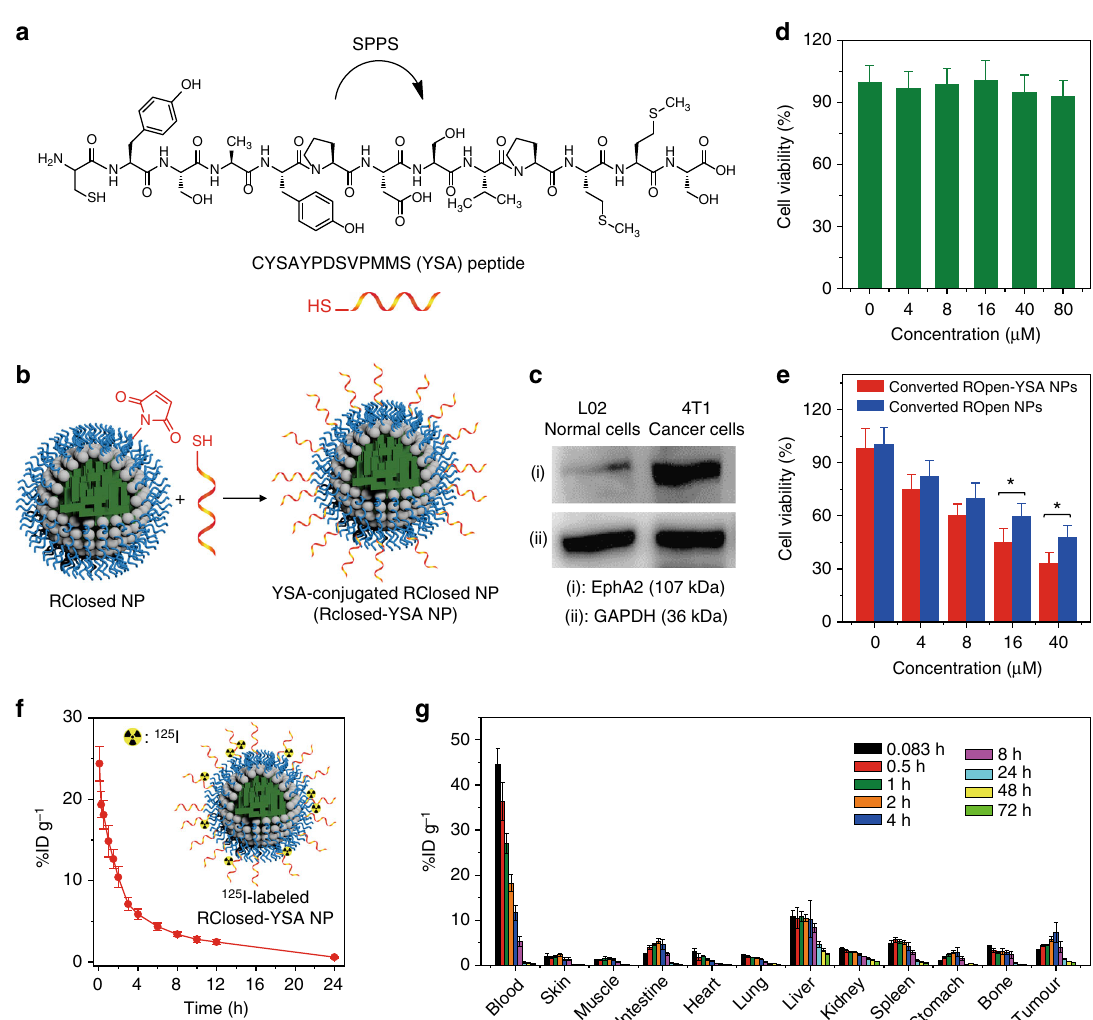
Fig. 5 Targeting modi fi cation, cytotoxicity and in vivo pharmacokinetics. a Chemical structure of CYSAYPDSVPMMS peptide. SPPS solid-phase peptide synthesis. b Schematic of the preparation of a RClosed-YSA NP. c Western blot analyses of EphA2 in L02 cells and 4T1 cancer cells. d Cell viability of RClosed-YSA NP-incubated 4T1 cancer cells after 610 nm red light (0.3 W cm − 2 ) irradiation for 5 min. Error bars, mean ± s.d. ( n = 4). e Cell viabilities of the converted ROpen-YSA NP-loaded and converted ROpen NP-loaded 4T1 cancer cells under white light irradiation (0.25 W cm − 2 , 4 min). Error bars, mean ± s.d. ( n = 4). * P < 0.05, unpaired Student's t -test (two-tailed). The cells were incubated with RClosed-YSA and RClosed NPs, respectively, followed by exposure to 610 nm red light (0.3 W cm − 2 ) for 5 min, to obtain the converted ring-opening NP-loaded cells. In d and e , the concentration is based on DTE-TPECM. f Pharmacokinetics study of 125 I-labelled RClosed-YSA NPs analysed by scintillation count of 125 I radioactivity in blood. Error bars, mean ± s.d. ( n = 6 rats). Inset displays the schematic of an 125 I-labelled RClosed-YSA NP. g Biodistribution of 125 I-labelled RClosed-YSA NPs in various tissues of 4T1 tumour-bearing mice at different time points post-intravenous injection. Error bars, mean ± s.d. ( n = 6 mice for each time